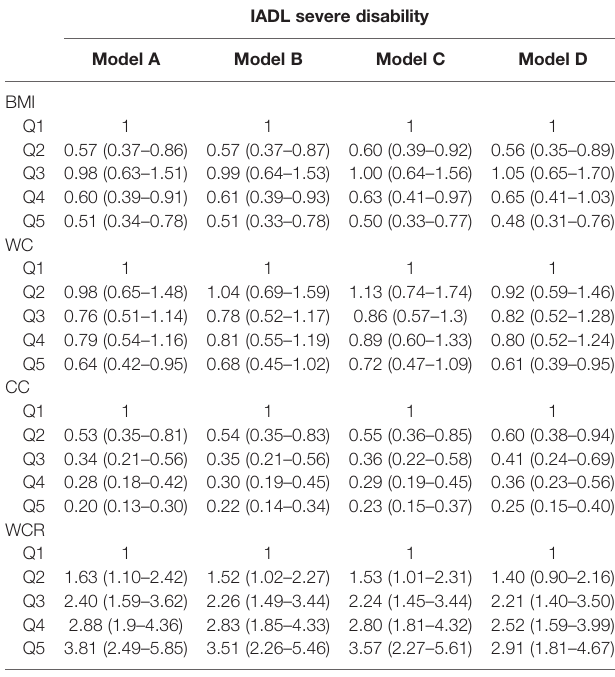
BMI,bodymassindex;WC,waistcircumference;CC,calfcircumference;WCR,waist-calf circumference ratio. Model A: crude model; Model B: Adjusted for gender, age; Model C: Adjusted for gender, age, ethnic, education level, residential type; Model D: Adjusted for gender, age, ethnic, education level, residential type, smoking, drinking, physical